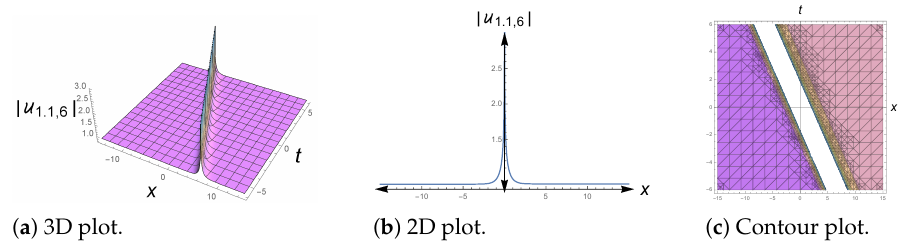
( a ) 3D plot. ( b ) 2D plot. ( c ) Contour plot. Figure 2. Graphical simulation of singular soliton solutions to Equation (42).